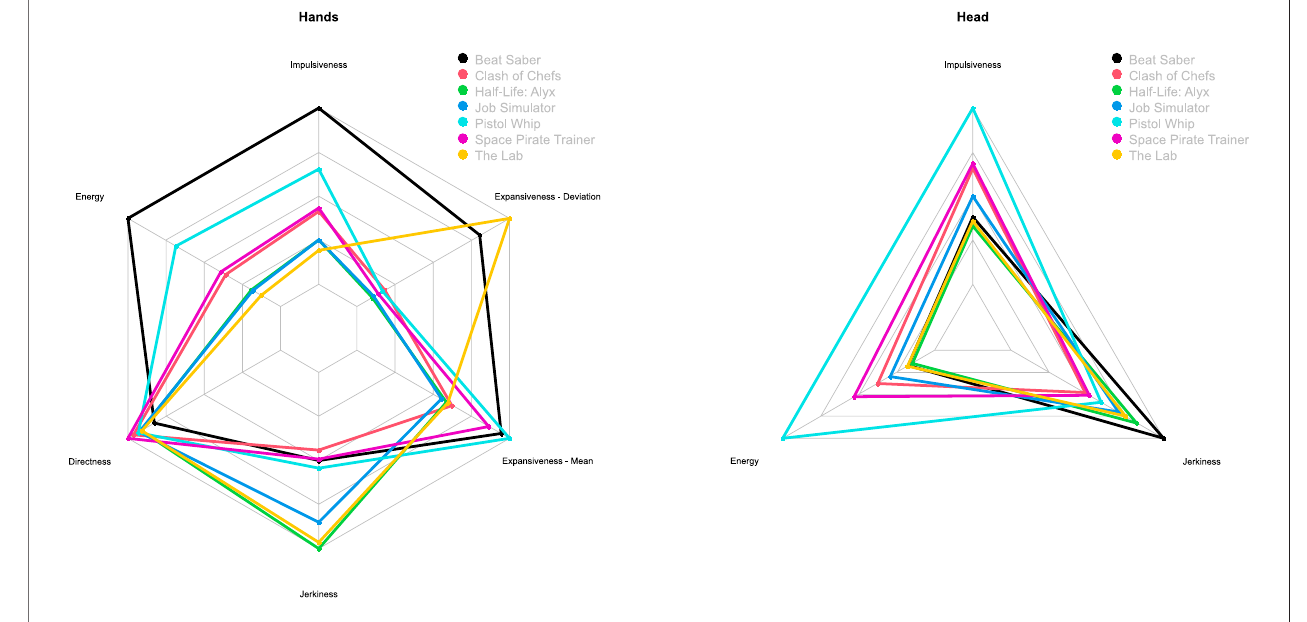
FIGURE 2 | The computed outcome of our metric for seven games with normalised scales.